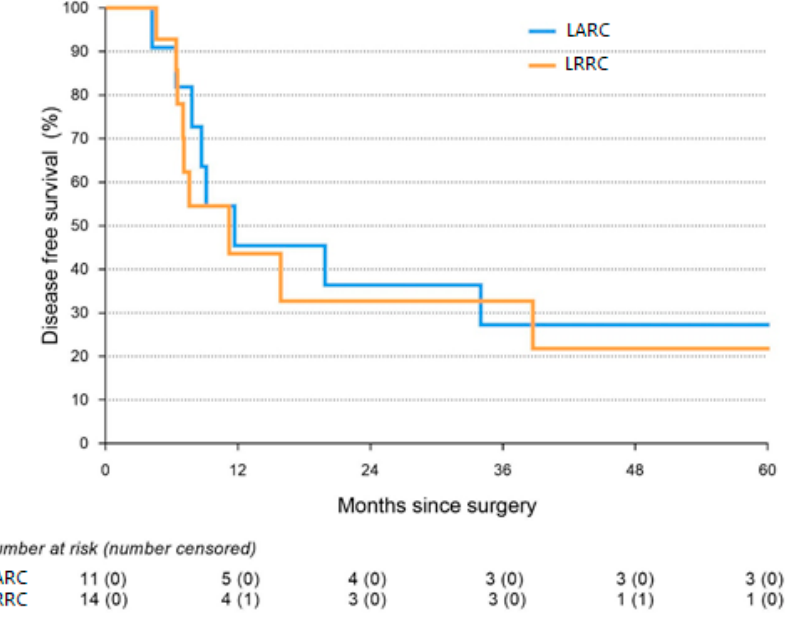
Figure 1. Kaplan-Meier graph of disease-free survival.